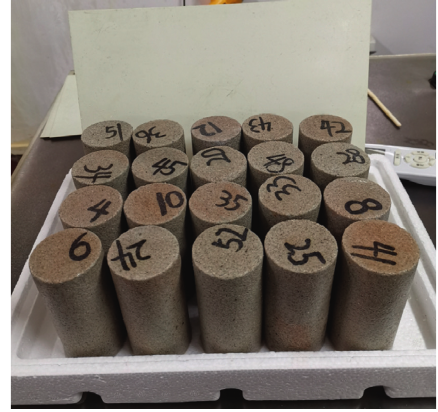
Figure 2: Sandstone